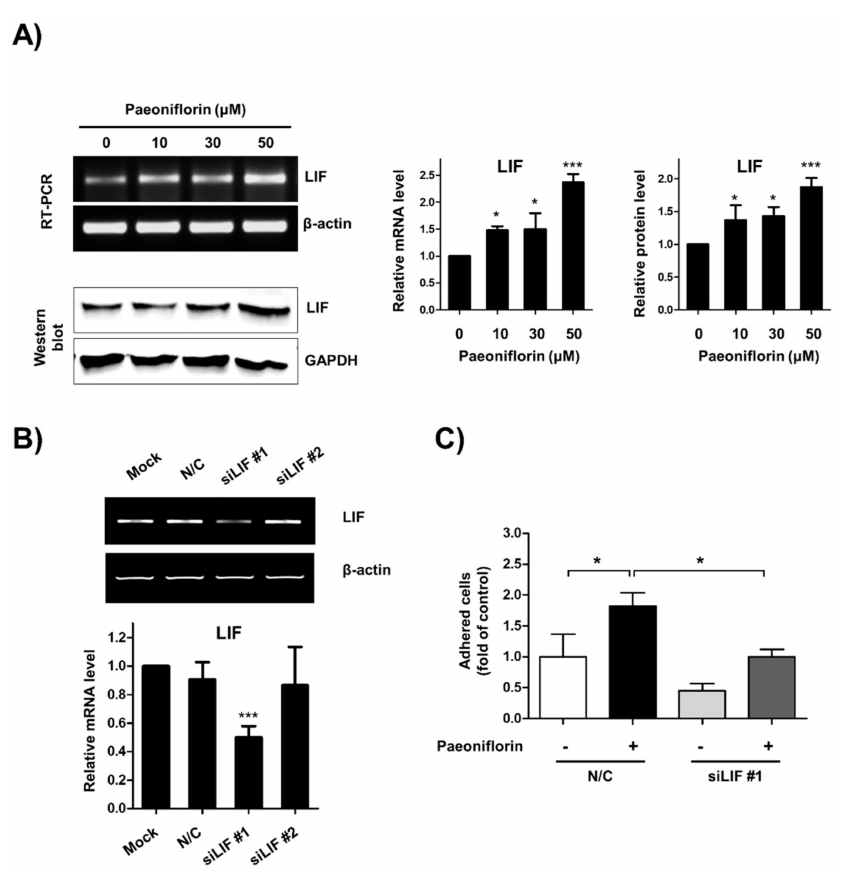
Figure 4. Paeoniflorin enhanced endometrial receptivity through expression of leukemia inhibitory factor (LIF). ( A ) Ishikawa cells were treated with 0, 10, 30, and 50 µ M paeoniflorin for 24 h. LIF expression was determined using reverse transcription polymerase chain reaction (RT-PCR) and Western blot analysis. β -Actin and glyceraldehyde 3-phosphate dehydrogenase (GAPDH) were internal controls. Relative mRNA and protein levels of LIF are shown as the mean ± standard error of the mean (SEM); * p < 0.1 and *** p < 0.001 compared to control (0 µ M). ( B ) Ishikawa cells were treated with carrier only (mock), negative control small interfering RNA (siRNA, N/C), and siRNA against LIF. After 24 h incubation, LIF expression was determined using RT-PCR. The relative mRNA level of LIF is shown as the mean ± standard error of the mean (SEM); *** p < 0.001 compared to mock. ( C ) Ishikawa cells were transfected with N/C or siRNA against LIF. These cells were treated with or whithout 50 µ M paeoniflorin for 48 h (labelled with +, -). Fluorescently labeled JAr cells were added to confluent Ishikawa cells. After incubation and washing, the number of attached JAr cells was counted and calculated as a fold-change compared to control, and the results are shown as the mean ± standard error of the mean (SEM); * p < 0.01 compared to each